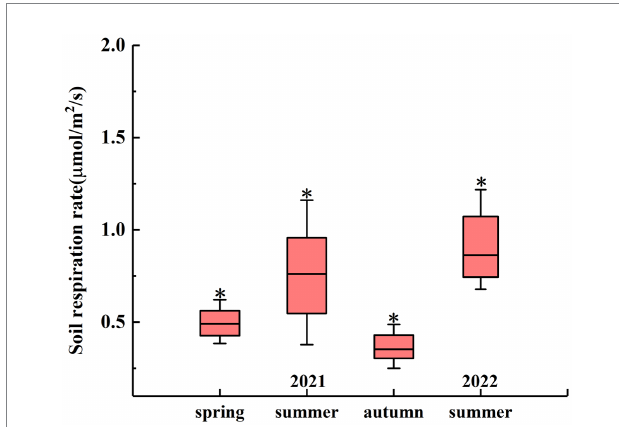
FIGURE 3 Seasonal R S rates from April 2021 to July 2022. The asterisk (*) indicates significant differences in R S rates between different seasons at a significance level of 0.05.